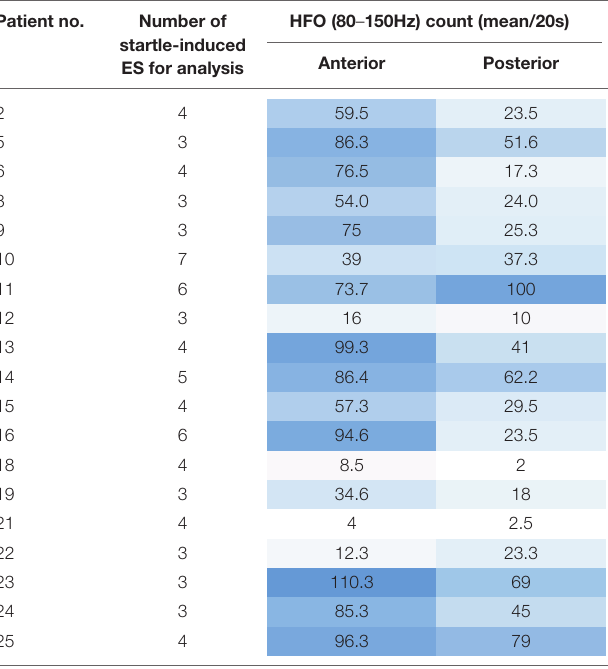
TABLE 3 | Ictal HFOs of ES on scalp EEG.